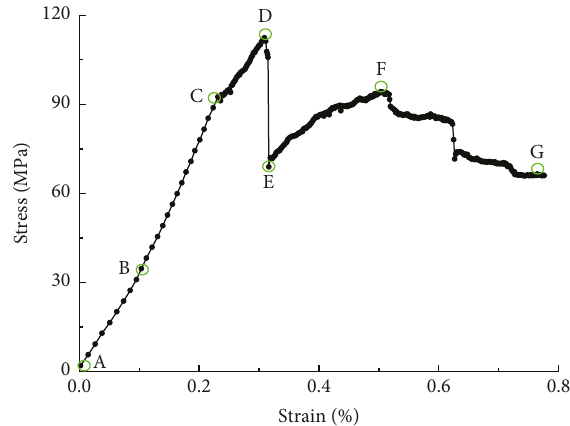
Figure 5: A sample stress-strain relationship curve of RCTMC samples: compaction stage (A-B section); linear elasticity stage (B- C section); crack propagation stage (C-D section); initial failure development stage (D-E section); cemented backfill bearing stress stage (E-F section); and secondary failure development stage (F-G